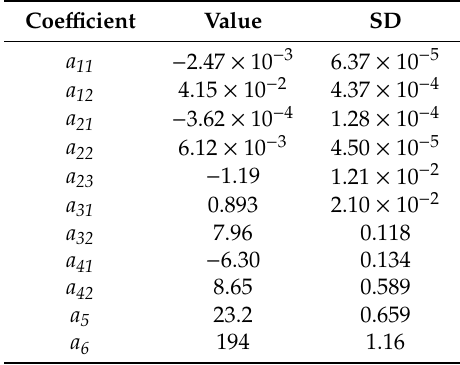
Table 7. Coe ffi cients of the reactor temperature profile